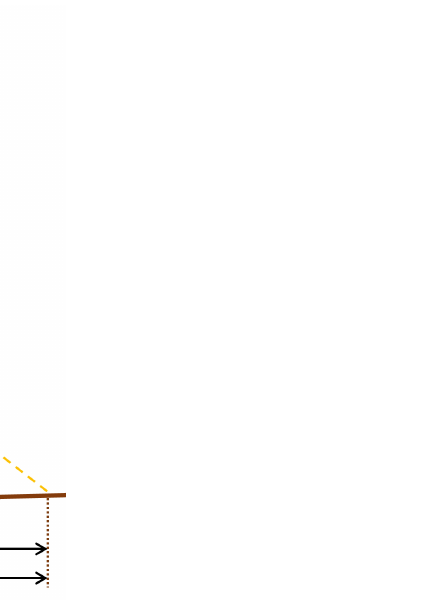
Figure 1. Cast shadow diagram depicting geometry parameters used to simulate the umbra and the penumbra regions of a cast